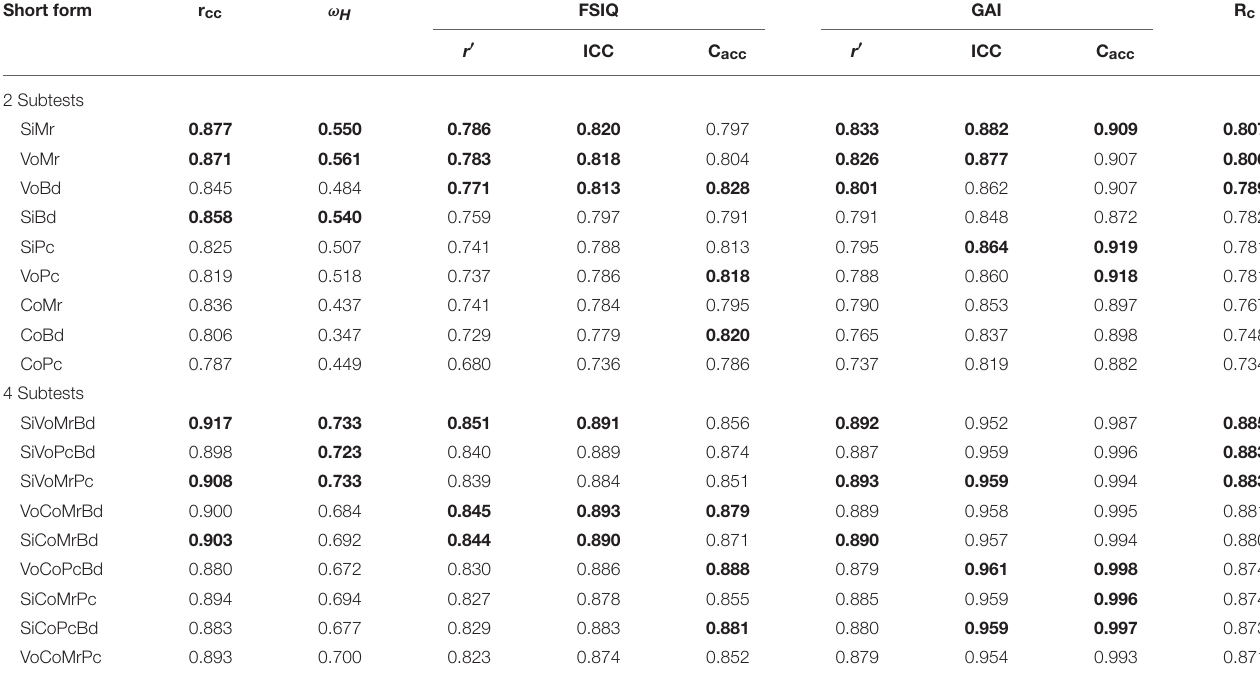
TABLE 4 | Reliability and Validity of WISC-IV Short Forms from simulated data. Short form